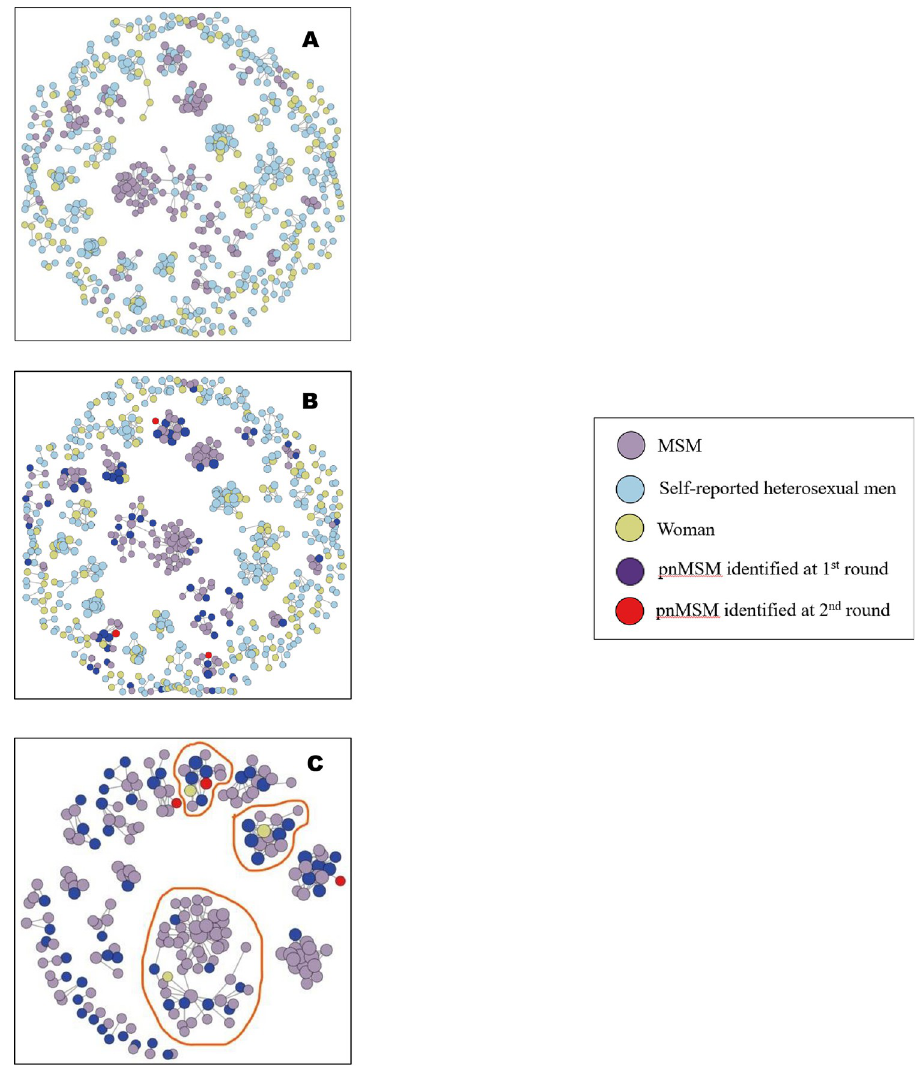
Fig 2. Cluster mapping of HIV-1 molecular network. 2-A is from self-reports; 2-B is from the analysis based on Fig 1 with pnMSM identified; 2-C shows 29 HIV-1 molecular clusters containing pnMSM where clusters surrounded by red loops indicate that they were comprised of self-reported heterosexual men, women, and MSM, while other clusters contained only MSM and self-reported heterosexual men. Singleton self-reported heterosexual men are omitted. A 143 HIV-1 molecular clusters containing self-reported heterosexual men and related nodes. B 143 HIV-1 molecular clusters containing self-reported heterosexual men and related nodes with potential non-disclosed men who have sex with men (pnMSM) identified (specified by dark purple and red dots). C 29 HIV-1 molecular clusters containing potential non-disclosed men who have sex with men (pnMSM). interpreted from the conventional case-control study. A risk ratio less than 1 indicates that the person in that specific level of the indendent variable were more likely to be pnMSM. The rela- tive risk of being a pnMSM increased with decreasing age group. Using < 40 years old as the referent group, subjects in the oldest age group were less likely to be classified as pnMSM. Sim- ilarly, other predictors for pnMSM included being single, and having a higher educational background. Other variables were not statistically significant.